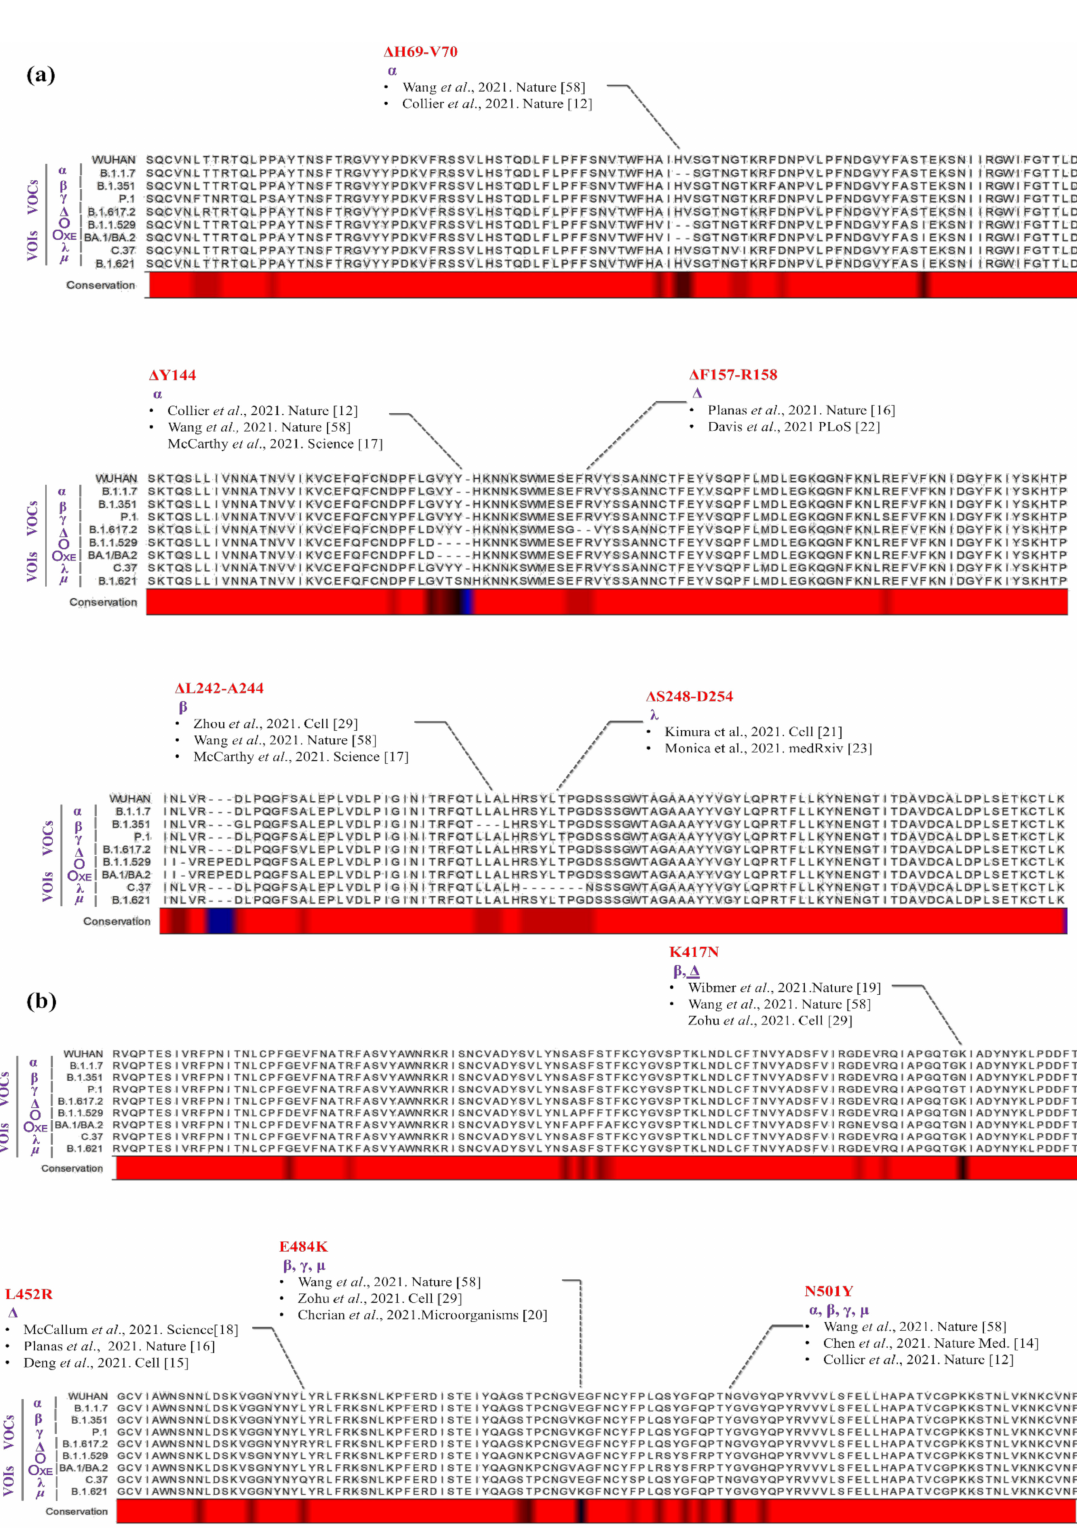
Figure 2. Multiple sequence alignment of NTDs and RBDs. Multiple sequence alignments of immuno- logically important regions ( a ) NTD ( b ) RBD of the SARS-CoV-2 VOCs and VOIs (as labeled) showing degree of sequence variations (black in red horizontal bar). Mutations known for their importance in the immune evasion are also highlighted with corresponding references